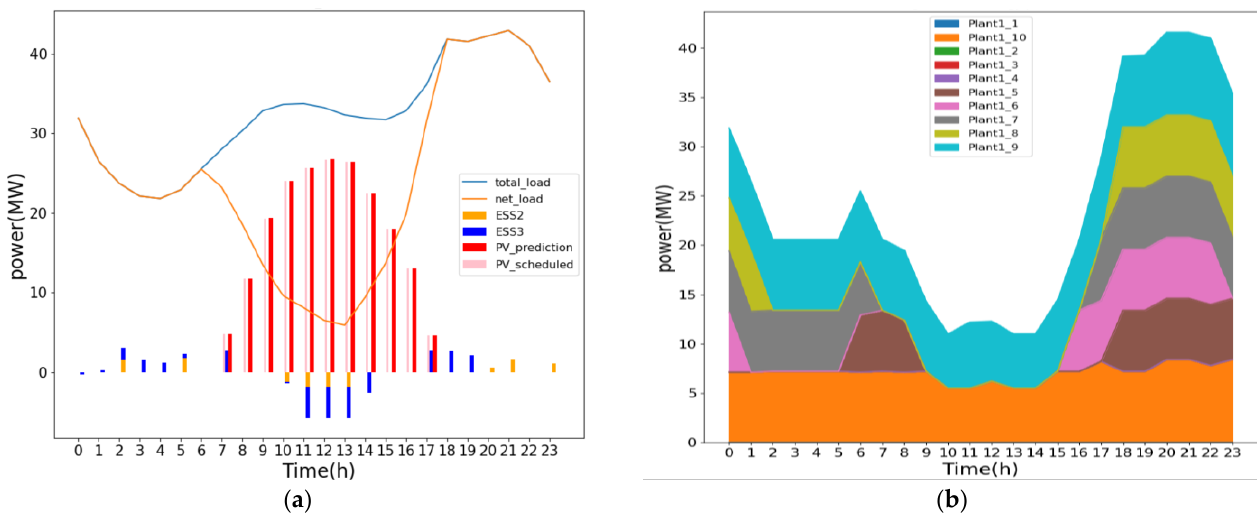
Figure 11. Case 1: result of second ED of ( a ) PV generation and the charge and discharge of ESS and ( b ) the power output of the diesel generators.